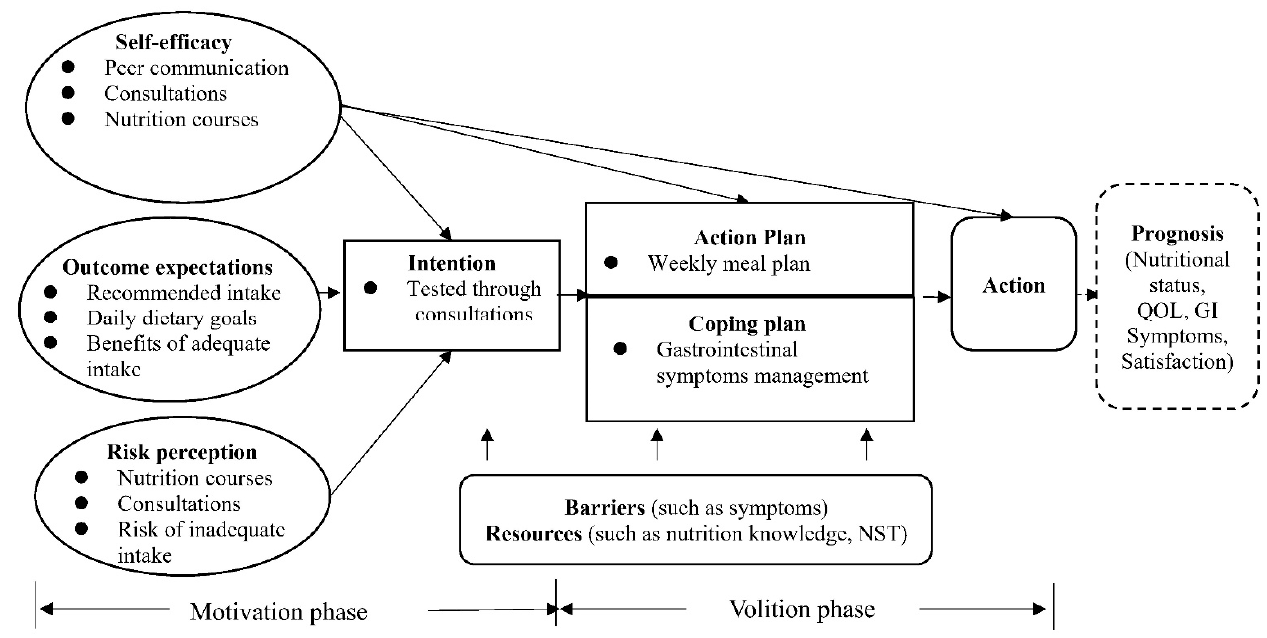
Figure 2. The Health Action Process Approach Theory.